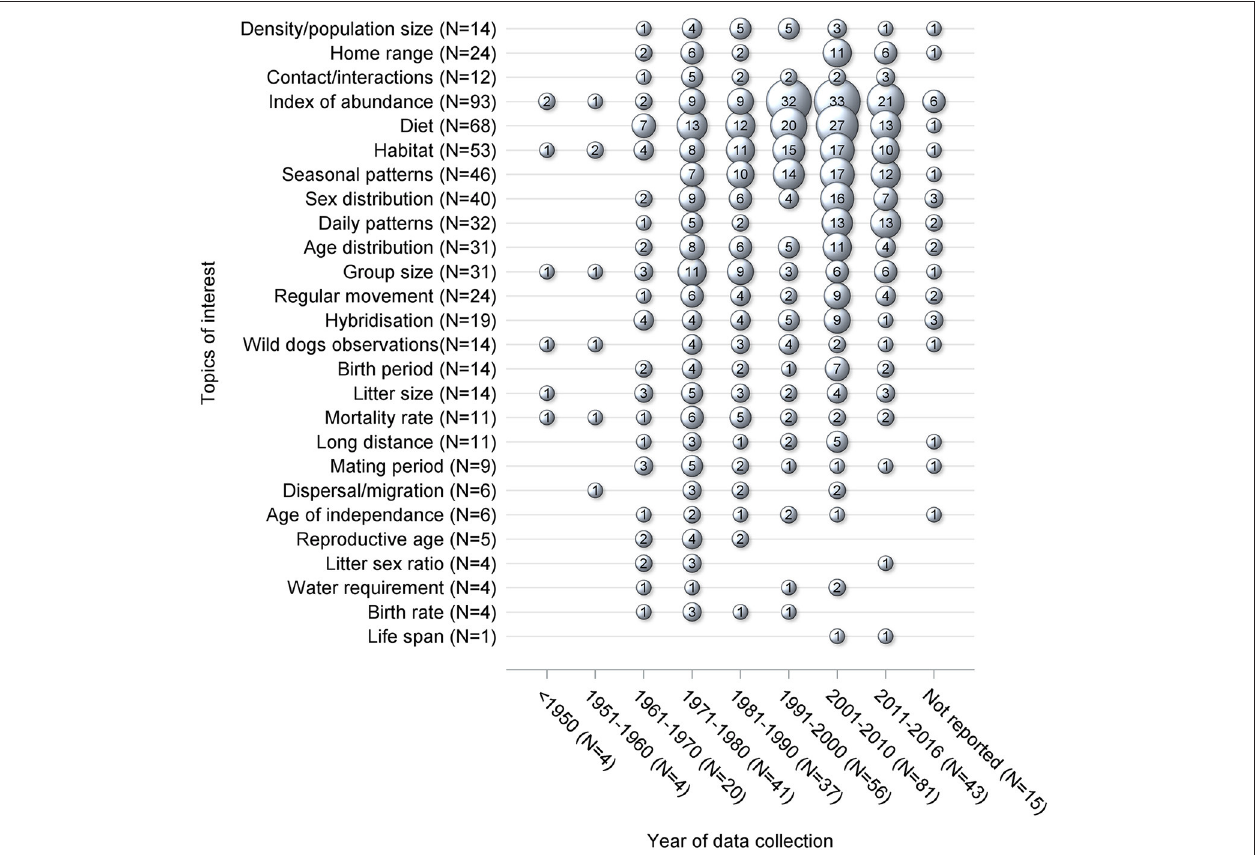
FIGURE 4 | Bubble plot of 229 studies, by year of collection, which were captured from a scoping review on the ecology and biology of dingoes, feral domestic dogs, and dingo-dog hybrids in Australia, targeting 28 specific topics of interest selected to inform disease spread models. Bubble sizes are directly proportional to the number of studies. For each topic of interest, the N stands for the number of studies reporting data of interest on the corresponding topic of interest. The sum of the bubble sizes for each column corresponds to the number of data of interest reported in the literature which was collected during that particular time period whereas the N stands for the number of studies reporting data of interest which was collected during the corresponding time